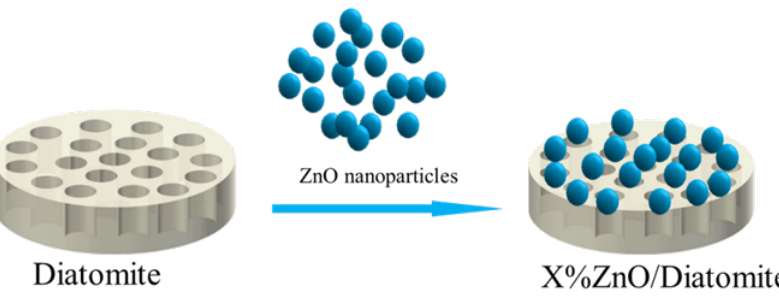
Figure 9. Schematic drawing of photocatalytic mechanism of ZnO@diatomite.